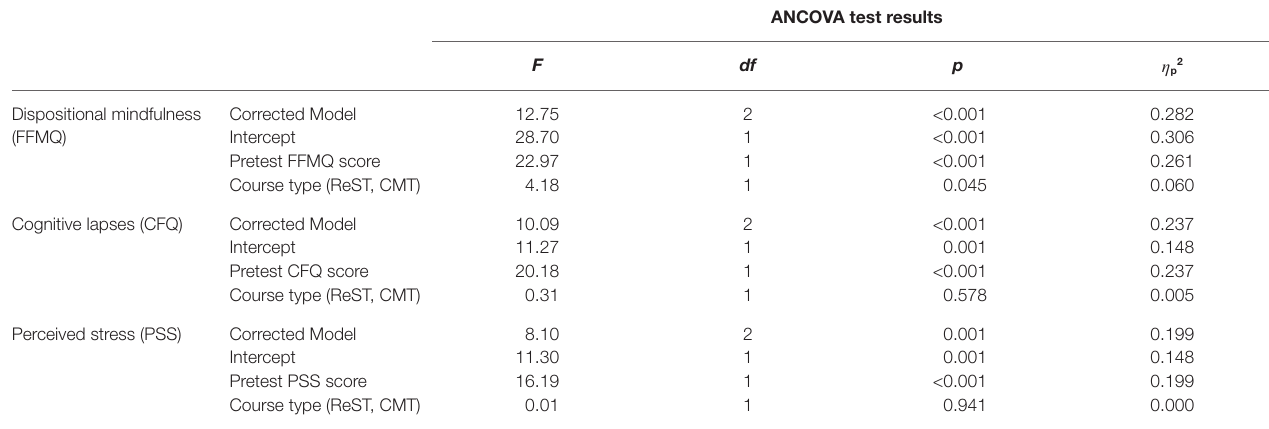
TABLE 1 | ANCOVA test results for the change scores representing the difference from before to 6 months after the restoration skills training (ReST) and conventional mindfulness training (CMT) courses in ratings of dispositional mindfulness with the Five Facet Mindfulness Questionnaire (FFMQ), cognitive lapses with the Cognitive Failures Questionnaire (CFQ), and perceived stress with the Perceived Stress Scale